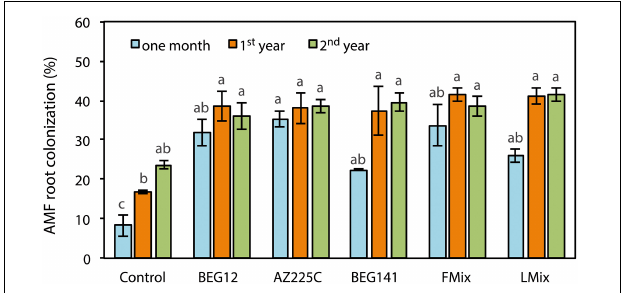
FIGURE 1 | Arbuscular mycorrhizal (AM) fungal root colonization of alfalfa ( Medicago sativa L.) as influenced by the interaction AM fungal inoculant [ Funneliformis mosseae BEG12, F. mosseae AZ225C, Rhizophagus irregularis BEG141, foreign mixture (FMix) (BEG12, AZ225C, and BEG141), local mixture (LMix) of 14 AM fungal species belonging to five families, and mock-inoculated control] and crop stage (1 month, 1-year and 2-year). Data are mean ± SE ( n = 3). Different letters indicate significant differences at P ≤ 0.001 ( Supplementary Table 2